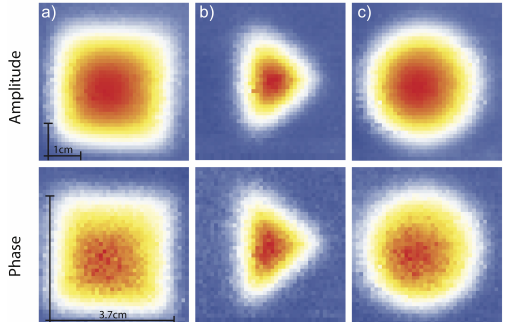
Figure 2. Proof-of-concept of EMI with atomic magnetometers. Images refer to ( a ) a square, ( b ) a triangle and ( c ) a disk of 2 mm aluminium. The first row shows the position resolved normalized amplitude of the ac magnetic field signal. The second row shows the corresponding normalized phase data. Adapted from